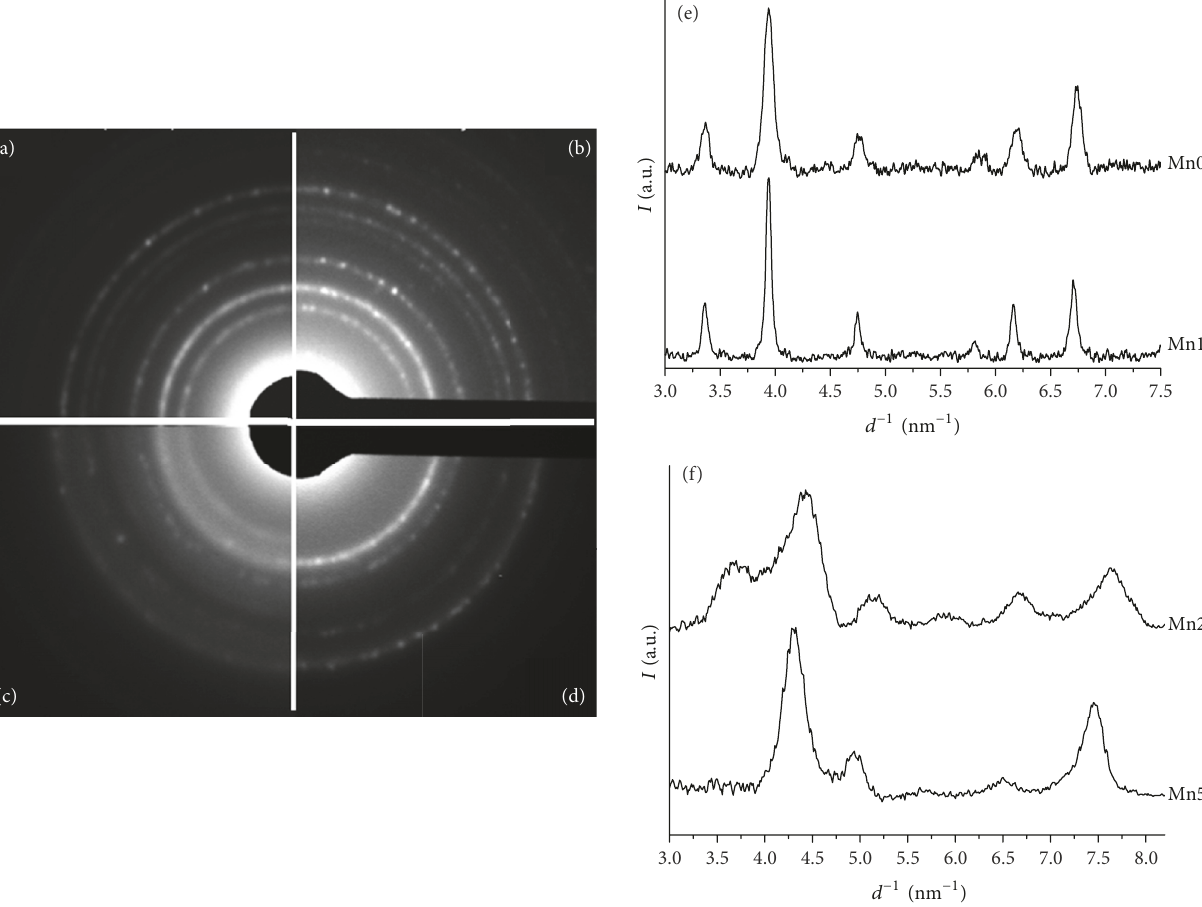
Figure 2: SAED measurements carried out on the samples: (a) Mn0, (b) Mn12, (c) Mn25, and (d) Mn50. (e) XRD spectra of Mn0 and Mn12 are plotted in the graph. Line profiles from SAED patterns of the samples Mn25 and Mn50 are reported in